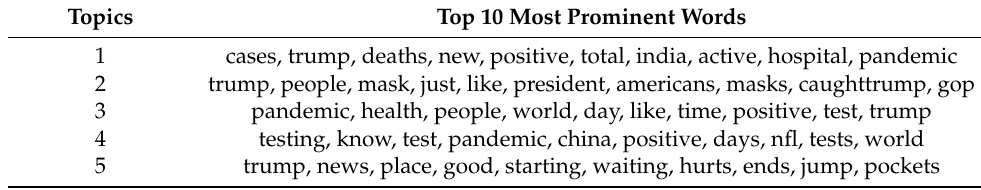
Figure 10. Inter-topic distance map for first dataset.